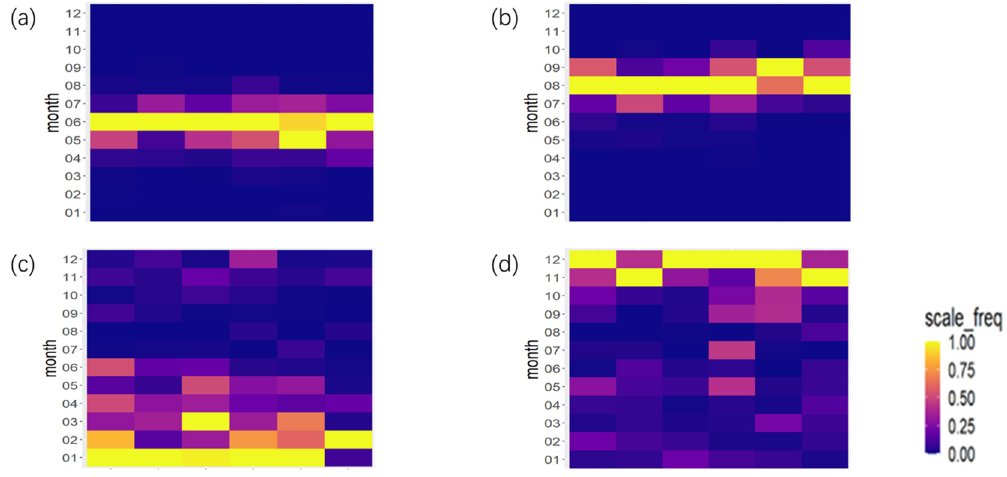
Figure 13. The distribution of the earliest occurrence date and the latest extinction date of heat waves were obtained based on the relative method. ( a ) and ( b ), respectively, show the distribution of the earliest occurrence date and the latest extinction date of heat waves in each month obtained by PTM. ( c ) and ( d ), respectively, show the distribution of the earliest occurrence date and the latest extinc- tion date of heat waves in each month obtained by FATM. ( e ) and ( f ), respectively, show the distri- bution of the earliest occurrence date and the latest extinction date of heat waves in each month obtained by VATM. 4. Conclusions and Discussion It is crucial to construct heat wave datasets from multiple angles, analyze the charac- teristics of heat waves, and derive their evolution characteristics to reduce the harm caused by heat waves to a certain extent. In this study, we used one absolute method and three relative methods to construct four heat wave datasets, counted four indicators of